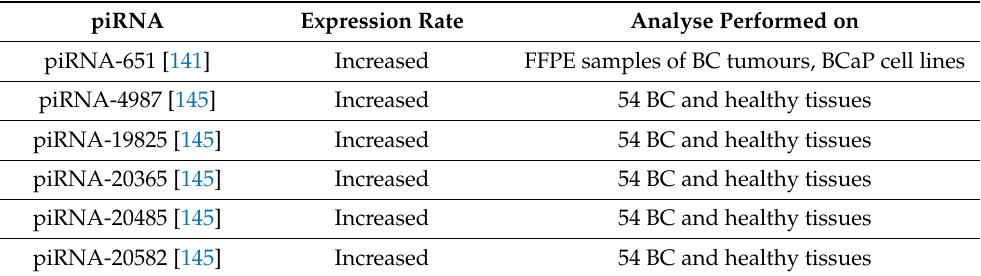
Table 2. Cont . piRNA Expression Rate Analyse Performed on piRNA-17485 [145] Increased 54 BC and healthy tissues piRNA-34736 [146] Increased piRNA-36249 [146] Increased piRNA-35407 [146] Increased piRNA-34377 [146] Increased piRNA-36318 [146] Increased piRNA-36026 [146] Increased piRNA-31106 [146] Increased piRNA-36743 [146] Increased piRNA-021285 [148] Increased piRNA -36712 [150] Decreased piR-sno 75 [155] Decreased 29 BC and healthy tissues, MCF-7 cell lines piRNA-932 [156] Increased